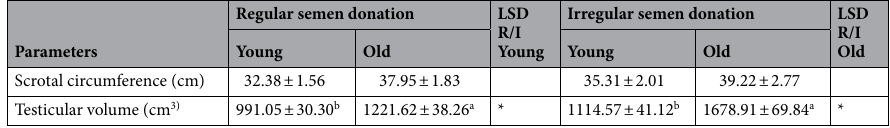
Table 12. Testicular biometry in young and old bulls during regular and irregular semen donation (mean ± SD). Explanation: Values with different letters (a, b) differ significantly between columns at P < 0.05, * P < 0.05; ** P <